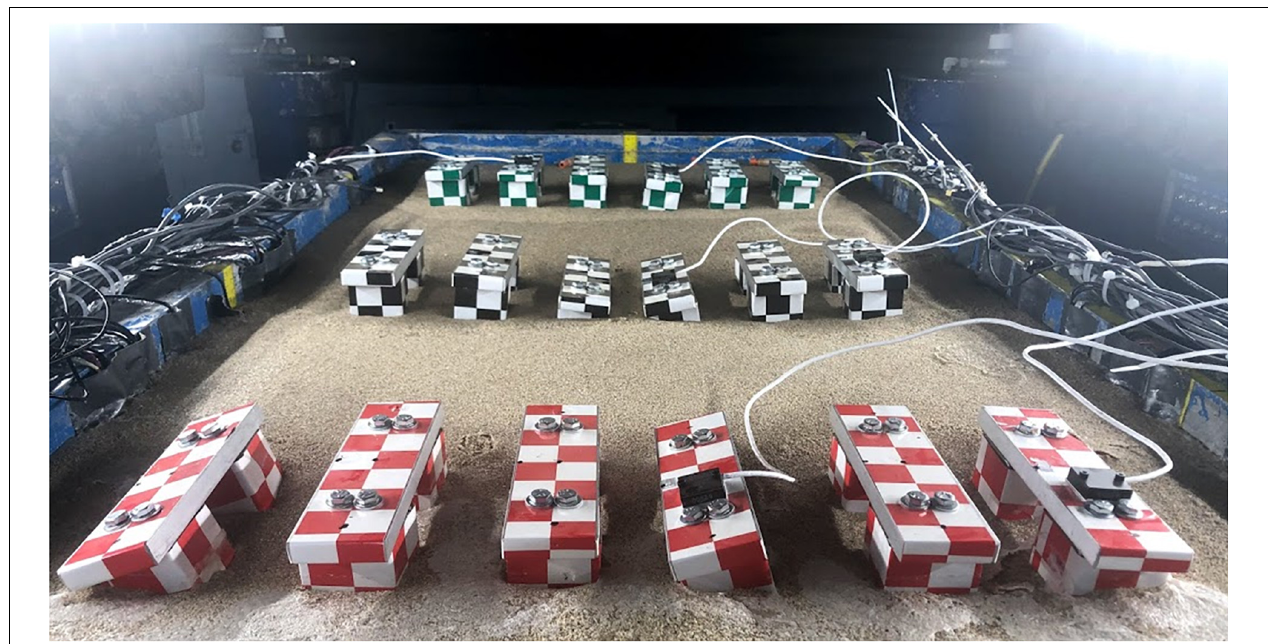
FIGURE 15 | Post-shaking photograph showing the variation of foundation settlements and tilting across the untreated, MICP 1 and MICP 2 treatment zones with liquefiable layers at shallow, medium, and deep intervals.